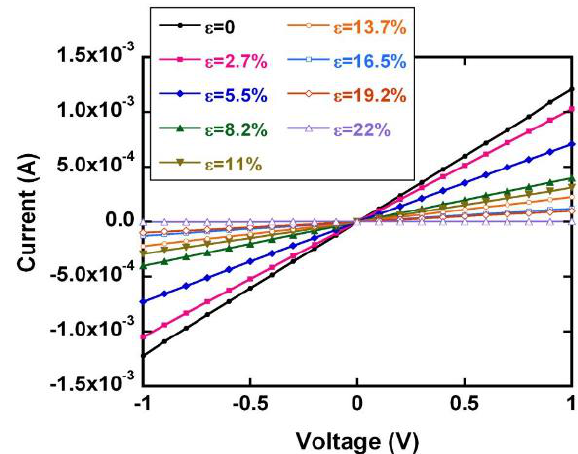
Figure 5. LRS current characteristics for the NT resistive memory under applied different ε values.